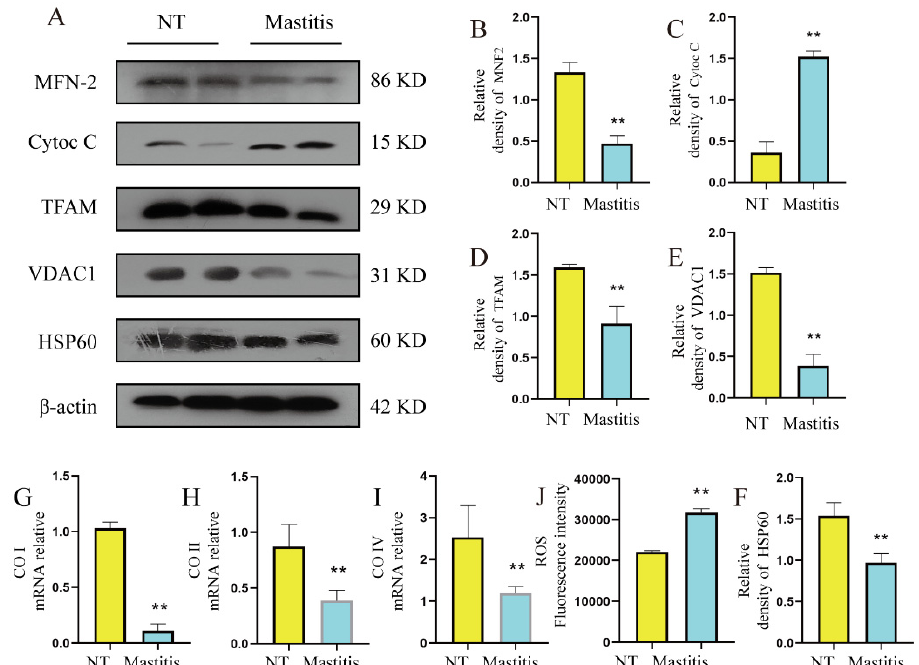
Figure 4. Mitochondrial damage in fibrotic mammary tissue. ( A ) The protein levels of MFN2, Cyto C, TFAM, VDAC1, HSP60, and β -actin in the mammary gland. ( B – F ) Quantification of MFN2, Cyto C, TFAM, VDAC1, HSP60 protein levels in mammary tissue, relative to β -actin. ( G – I ) The mRNA expression levels of CO Ⅰ , CO Ⅱ , CO Ⅳ , in mammary tissues. ( J ) ROS content in mammary gland tissue of dairy cows. Data were analyzed by the unpaired t -test method. The data error is presented in the form of mean ± SEM. The results of the experiment are the result of three independent repeated experiments. ** p < 0.01 compared with the control group.